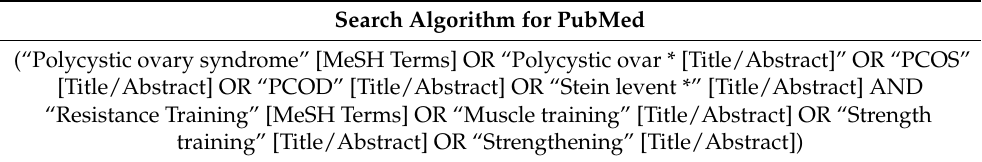
Table 2. Search algorithm for PubMed which was adapted for additional databases. Search Algorithm for PubMed